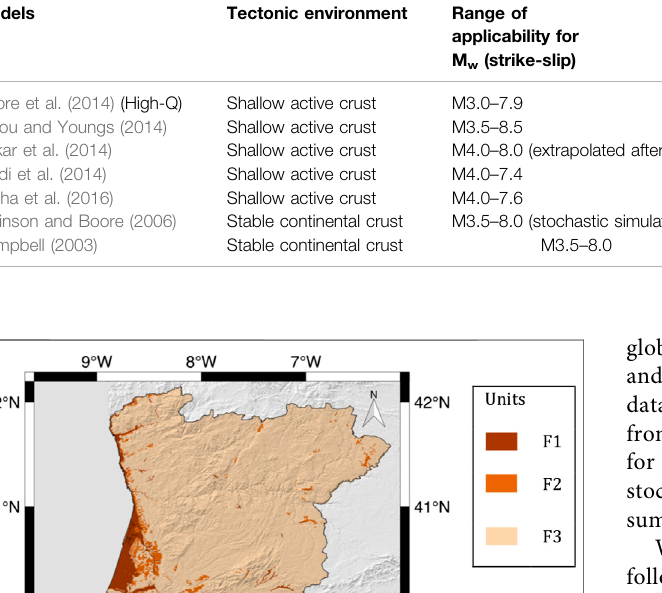
TABLE 2 | Ground motion models used in the Scenarios Calculations. Models